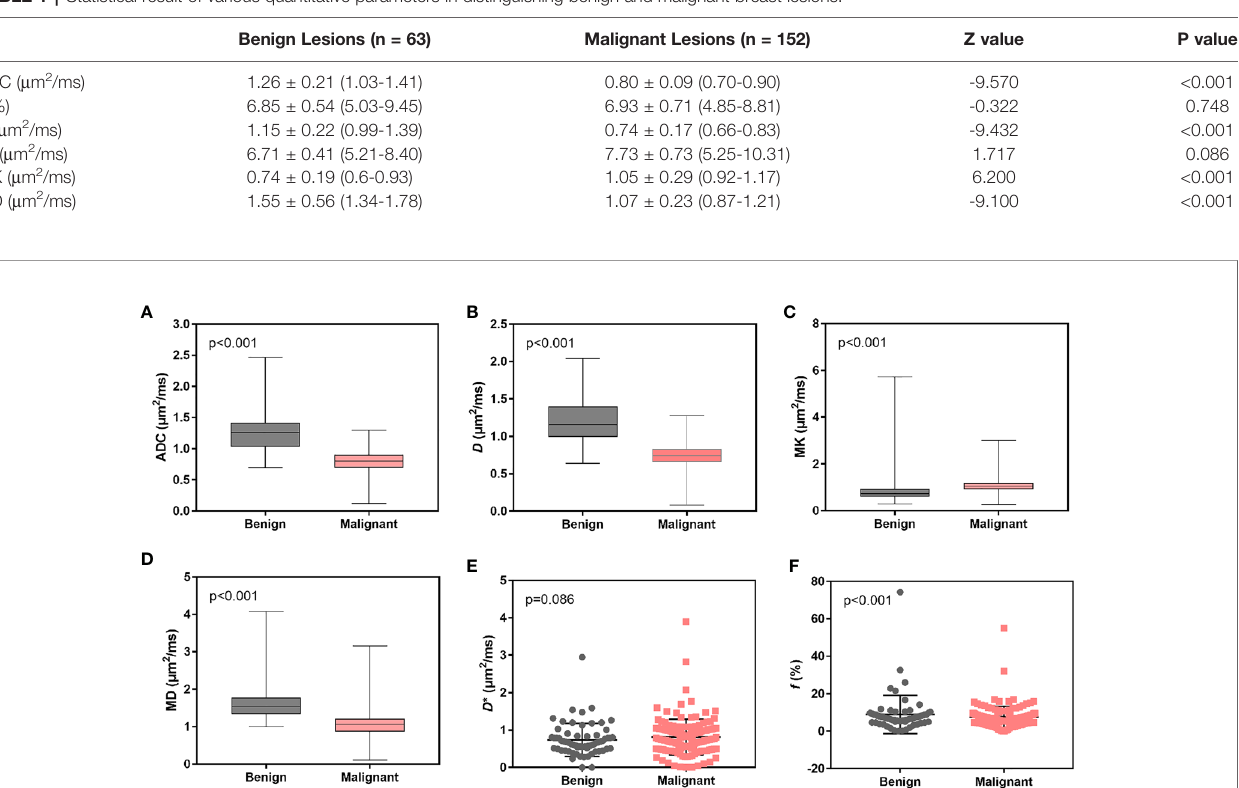
TABLE 1 | Statistical result of various quantitative parameters in distinguishing benign and malignant breast lesions.